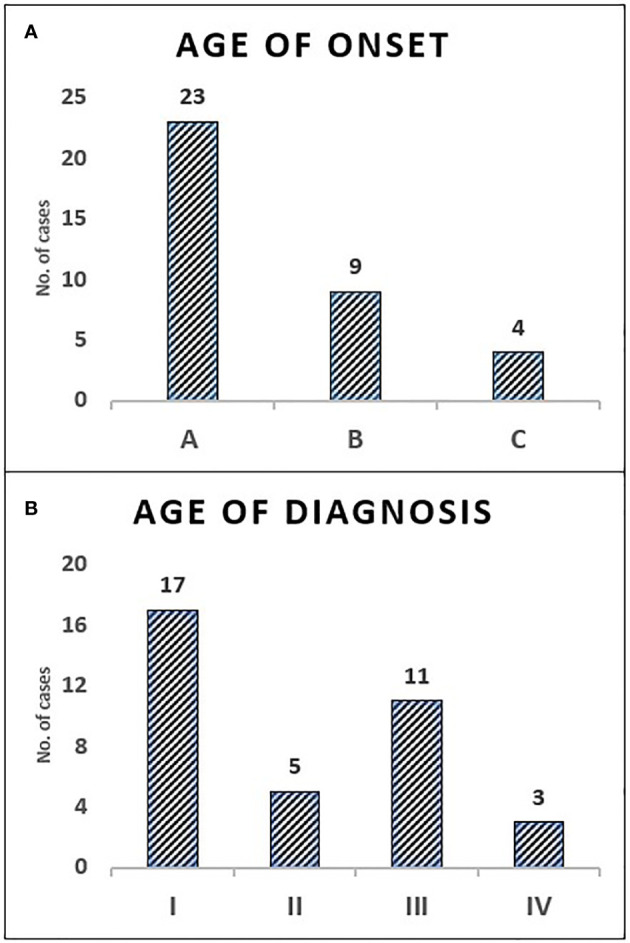
The distribution of children with SCID in categories of age—onset and diagnosis. Onset age category A: (0–3 months) 63.9%, B: (4–6 months) 25%, C: (7–12 months) 11.1% (A). Diagnosis age category I: (0–3 months) 47.2%, II: (4–6 months) 13.9%, III: (7–12 months) 30.6%, IV: (>12 months) 8.3% (B).